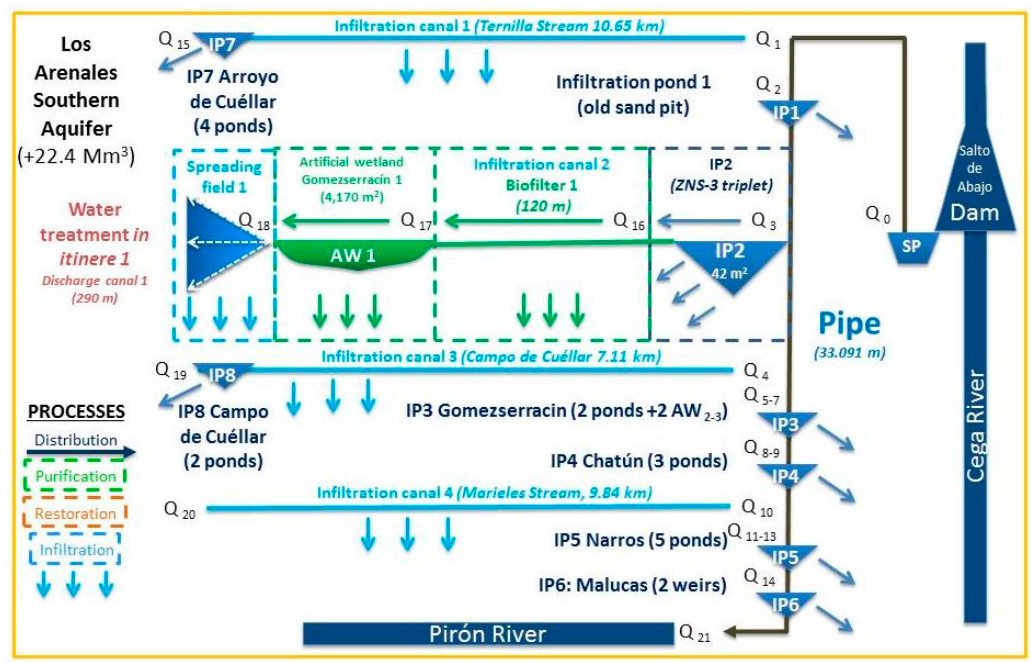
Figure 7. El Carracillo Area and its MAR sites. Devices, junctions, and functions, Segovia (Spain).